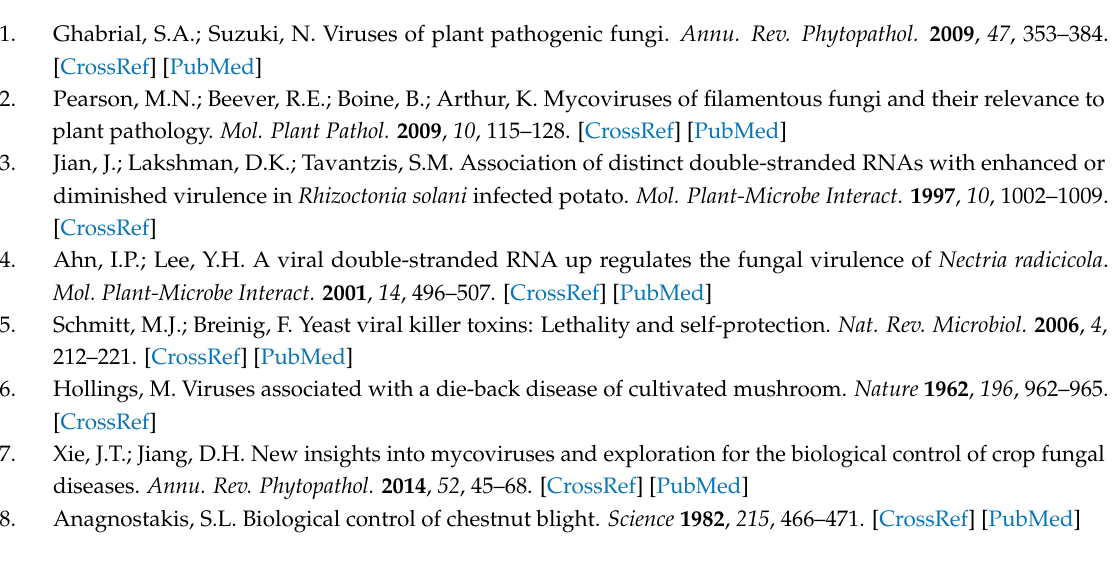
M, DNA marker; ITS, Internal Transcribed Spacer, Table S1. List of Sclerotinia minor strains used in the study; Table S2. Primers/adaptor used in this study and their oligonucleotide